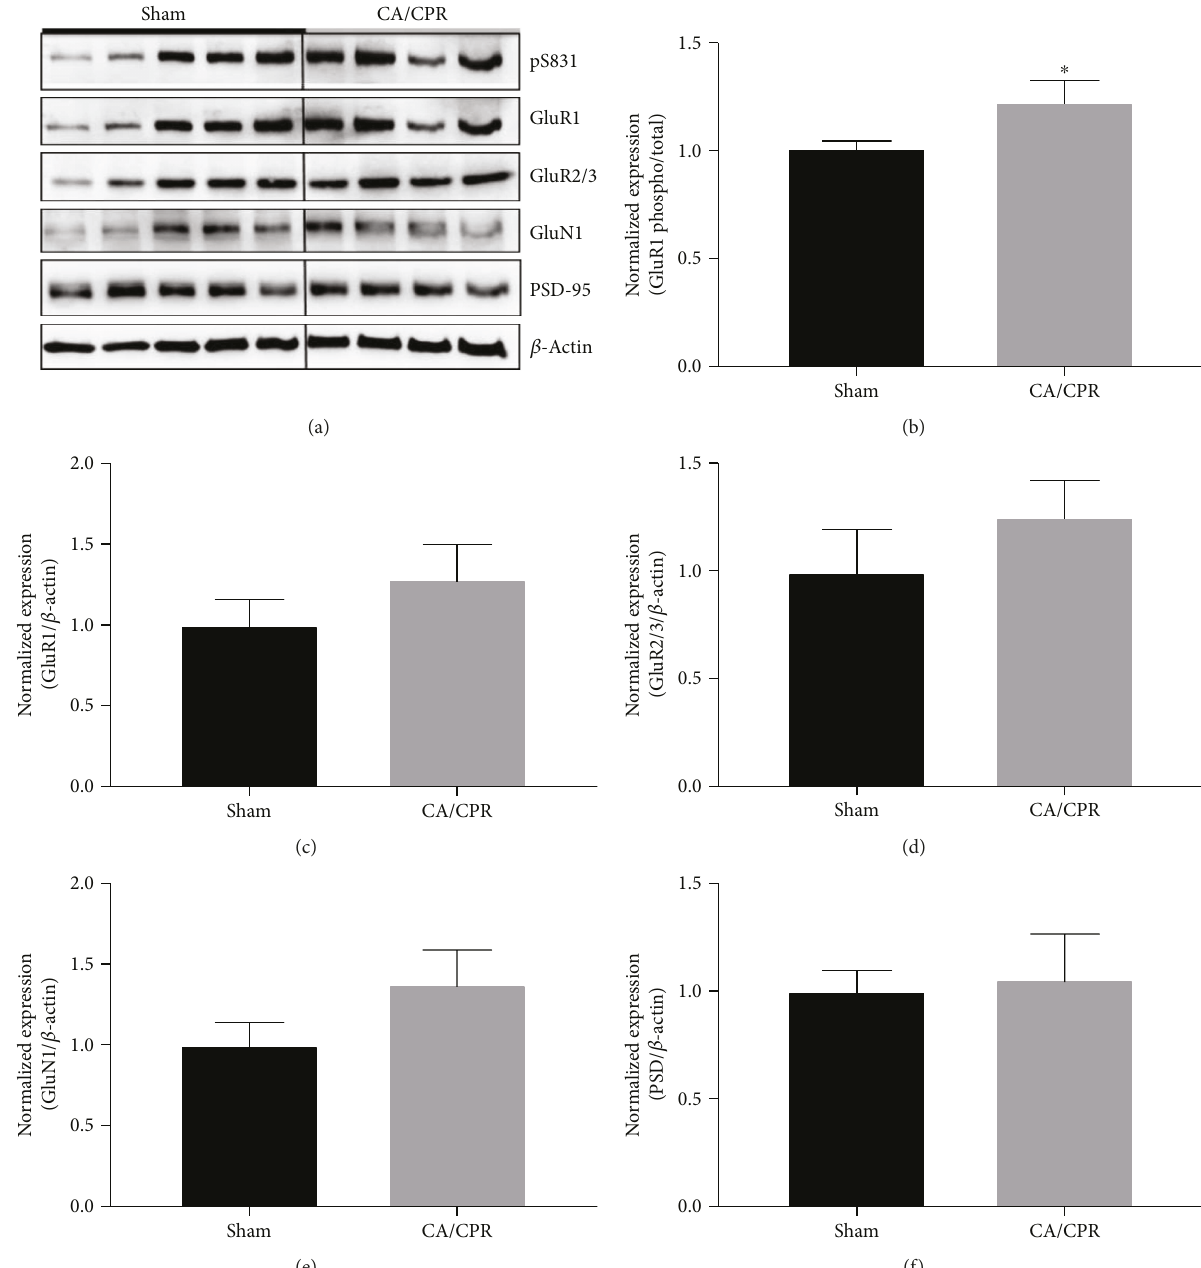
Figure 2: Increased AMPA receptor phosphorylation after CA/CPR. (a) Representative blots of protein expression from synaptic fractions of sham and CA/CPR hippocampus. Blots were cropped to show bands at molecular weight for indicated proteins. (b) Normalized phosphorylated S831: total GluR1 expression was calculated for each sample by dividing optical density of phosphoS831 by total GluR1 density within the same blot. (c) Normalized GluR1 expression was calculated for each sample by dividing optical density of total GluR1 by β -actin density within the same blot. (d) Normalized GluR2/3 expression was calculated for each sample by dividing optical density of total GluR2/3 by β -actin density within the same blot. (e) Normalized GluN1 expression was calculated for each sample by dividing optical density of total GluN1 by β -actin density within the same blot. (f) Normalized PSD-95 expression was calculated for each sample by dividing optical density of PSD-95 by β -actin density within the same blot. Values were normalized to sham controls. Shams ( n = 7 ) and CA/CPR ( n = 6 ) groups were compared using Student ’ s t -test. ∗ indicates p < 0 05